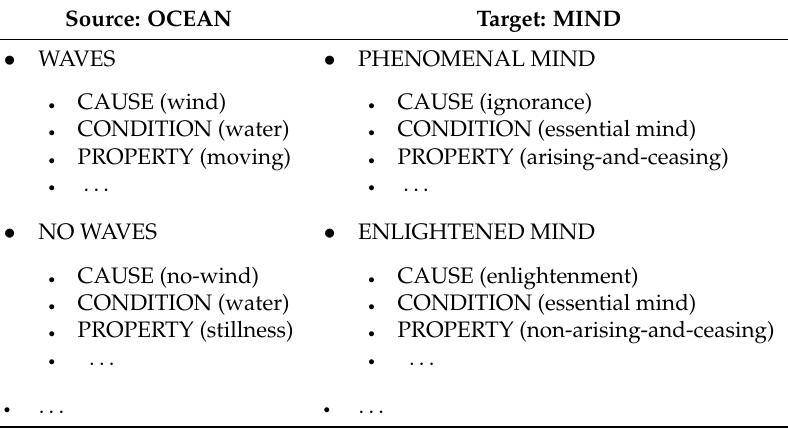
Table 3. Selected analogical mapping from OCEAN to